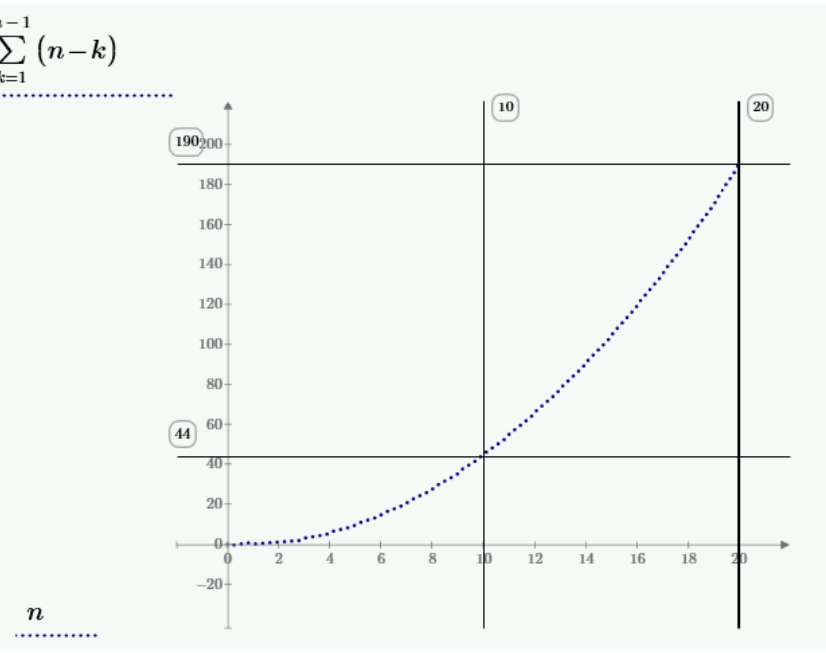
Figure 5. The number of points in the centroid function in accordance to the relation (14).